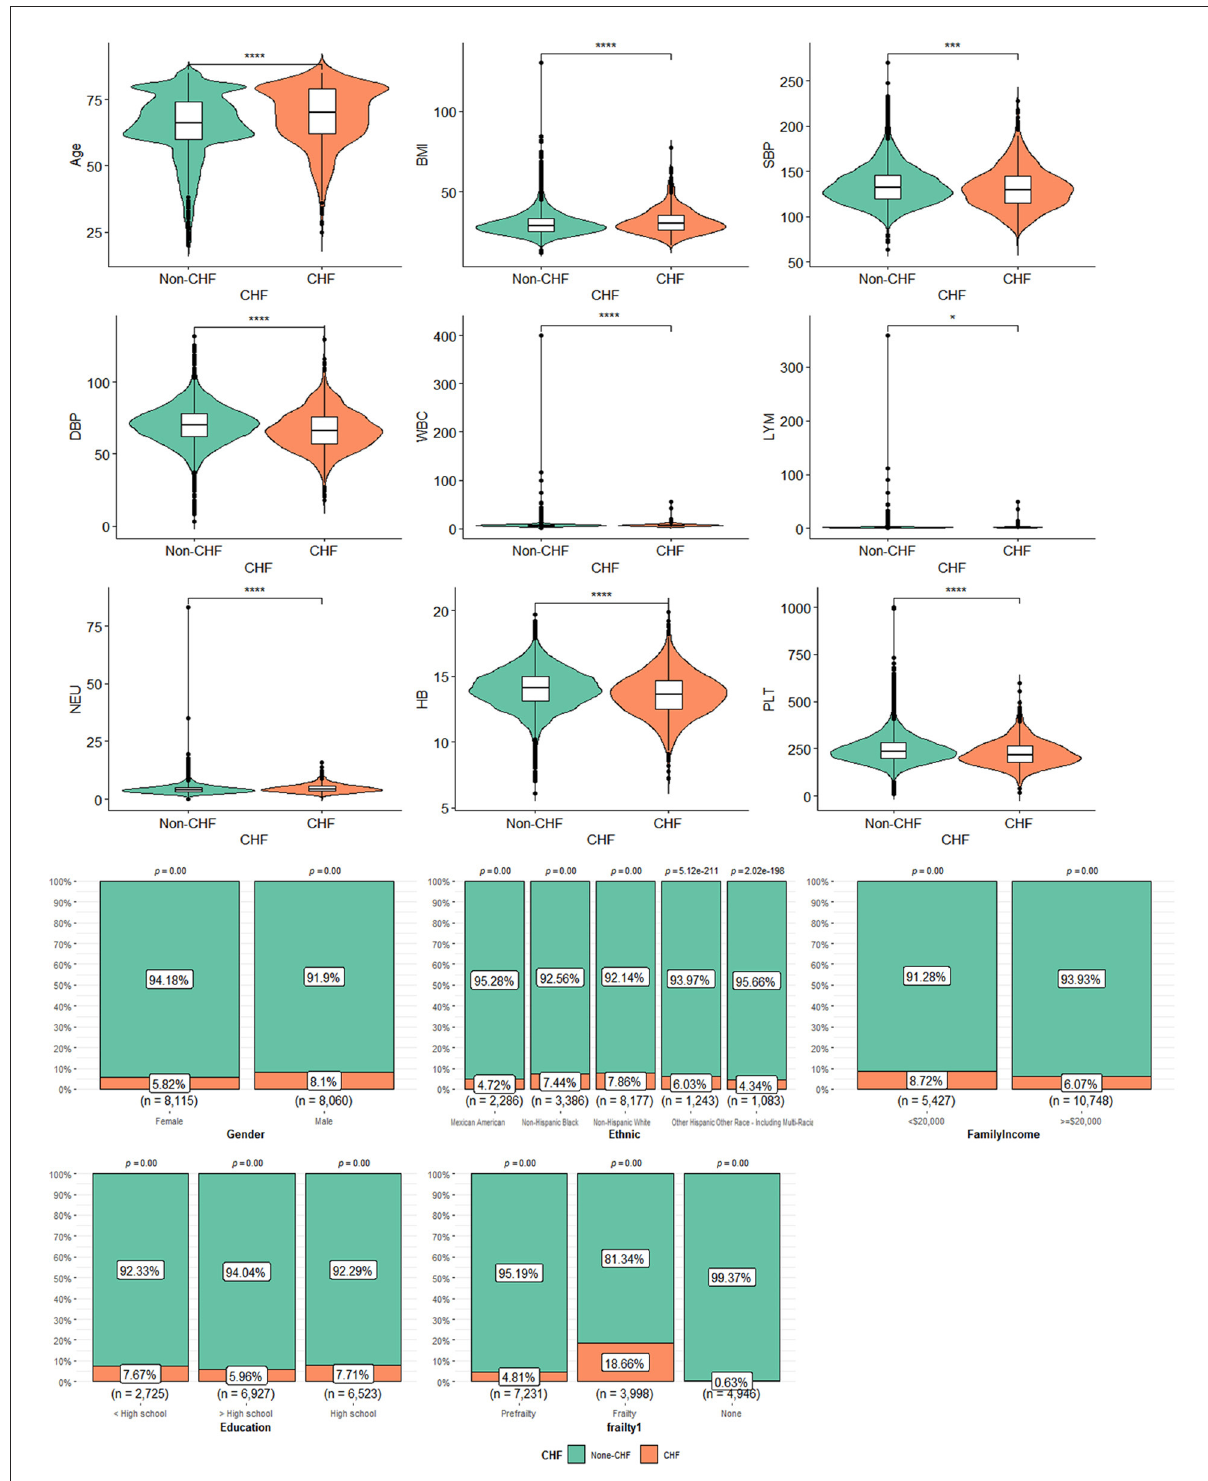
FIGURE2 The characteristics of participants with or without CHF: *means P < 0.05; ***means P < 0.001; ****means P <